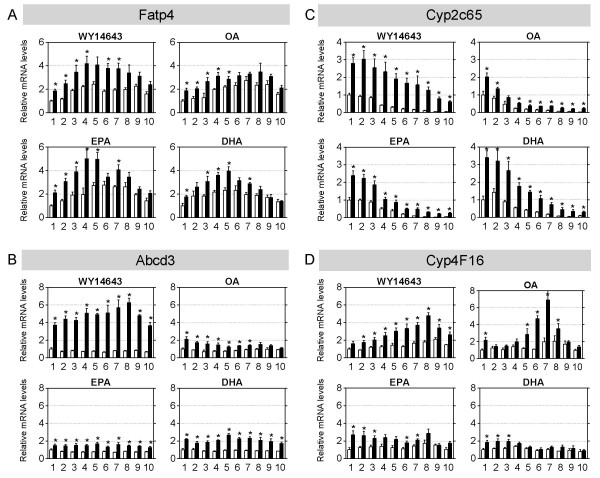
Expression of PPARα-dependently regulated genes along the longitudinal axis of treated PPARα-null and wild-type mice. QPCR was used to determine relative expression levels of PPARα-dependently regulated genes in sections isolated along the proximal-distal axis of the small intestine from PPARα-null mice (white, open bars) and wild-type mice (black, closed bars) that were acutely treated (6 hr) with the 4 agonists (n = 4 per group). The small intestine was divided into 10 equal parts; part 1 refers to the most proximal part (duodenum), part 10 refers to the most distal (terminal ileum). Messenger RNA levels were standardized to cyclophilin; part 1 of the PPARα-null mice was arbitrarily set to 1. White bars represent the PPARα-null mice, black bars represent the wild-type mice. Significance of treated WT versus treated KO mice was determined per segment using an unpaired student's t-test. * p-value < 0.05. Data are presented as mean ± standard error. A) fatty acid transport protein 4 (Fatp4). B) ATP-binding cassette, sub-family D, member 3 (Abcd3; ALD). C) cytochrome P450, family 2, subfamily c, polypeptide 65 (Cyp2c65). D) cytochrome P450, family 4, subfamily f, polypeptide 16 (Cyp4f16).